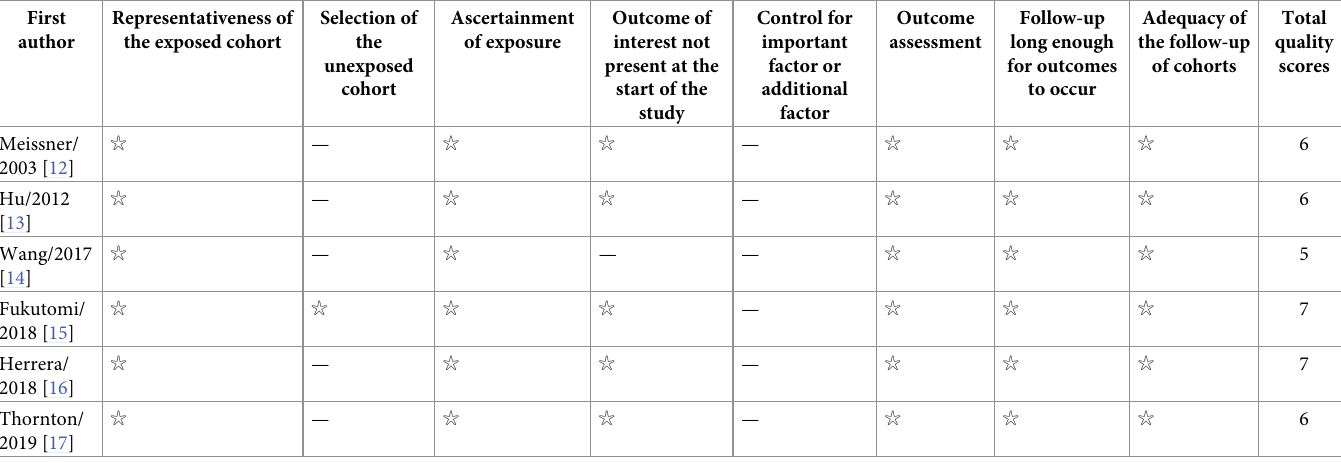
Table 2. Methodological quality of observational studies included in the